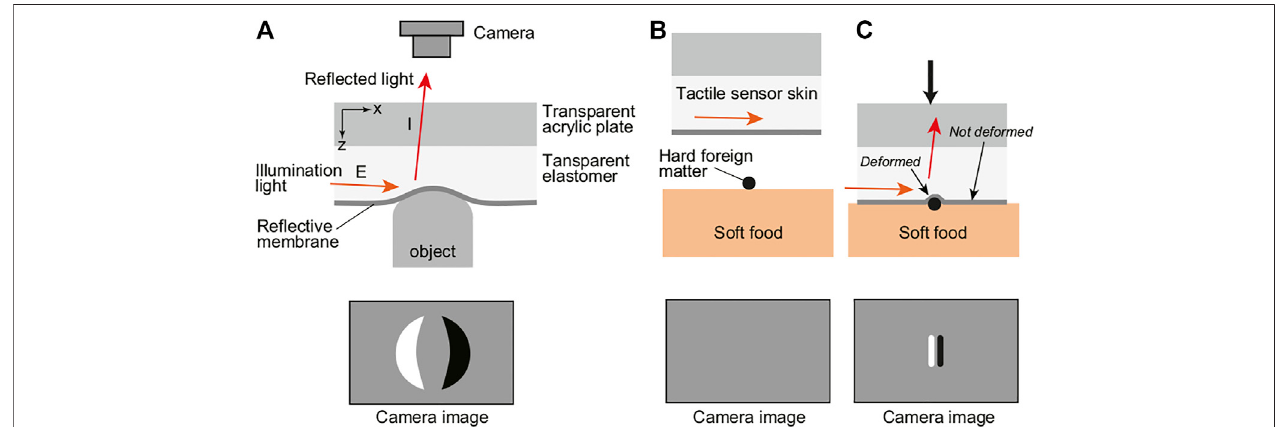
FIGURE 1 | Principle of contact sensing with the tactile image sensor and detection of foreign bodies in soft foods. (A) basic structure of the re fl ective membrane- based tactile image sensor. Because the illumination light was installed only on the left side of the fi gure, the left side of the deformation which is exposed to the illumination lightlooks bright on the camera image, and the right side looks dark on the camera image due to the shadow. (B) and (C) mechanism ofdetection of foreign bodies. When pressing the soft food by the tactile sensor, the soft food which is softer than the elastomer in the sensor deforms and the sensor skin does not deforms. Since the foreign body is harder than the sensor skin, deformation of the sensor skin occurs at this point, and it can be detected on the camera image.